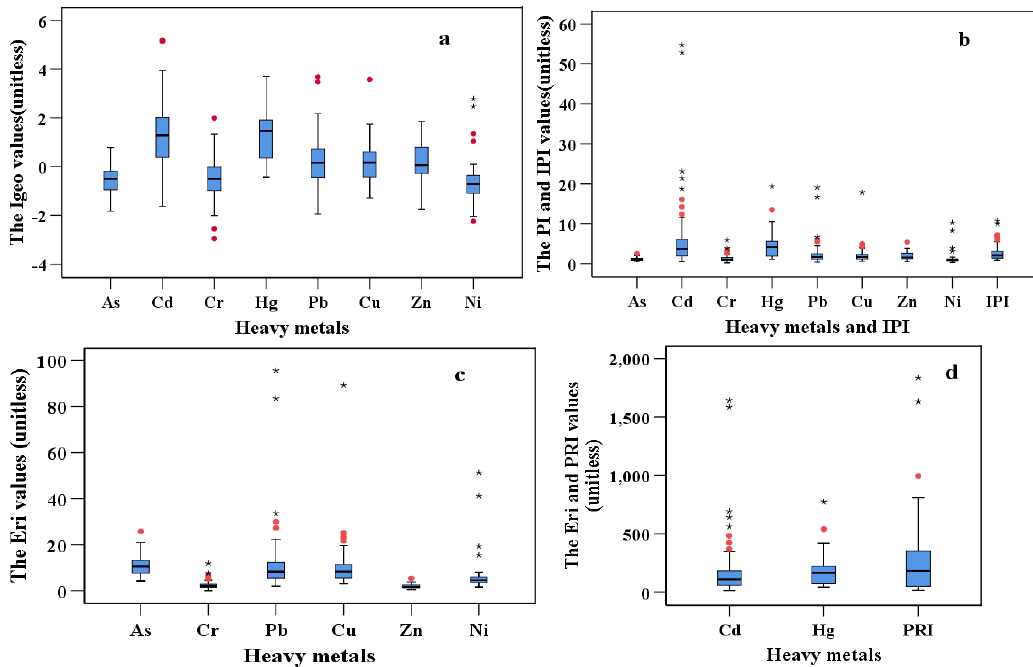
Figure 3. Box-plots of the geoaccumulation index ( Igeo ), pollution index ( PI ), integrated pollution index ( IPI ), ecological risk ( E i r ) and potential ecological risk index ( PRI ) of heavy metals in urban soil around China. The top and bottom edges of the boxes represent the 75th and 25th percentiles, respectively; the upper and lower limits of the whiskers represent the maxima and minima, excluding the outliers; the black horizontal lines inside each box represent the median values; the red dots represent mild outliers; and the black stars represent extreme outliers. ( a ): Box-plots of Igeo of heavy metals in urban soil around China. ( b ): Box-plots of PI and IPI of heavy metals in urban soil around China. ( c ): Box-plots of E i r of heavy metals in urban soil around China. ( d ): Box-plots of E i r and PRI of heavy metals in urban soil around